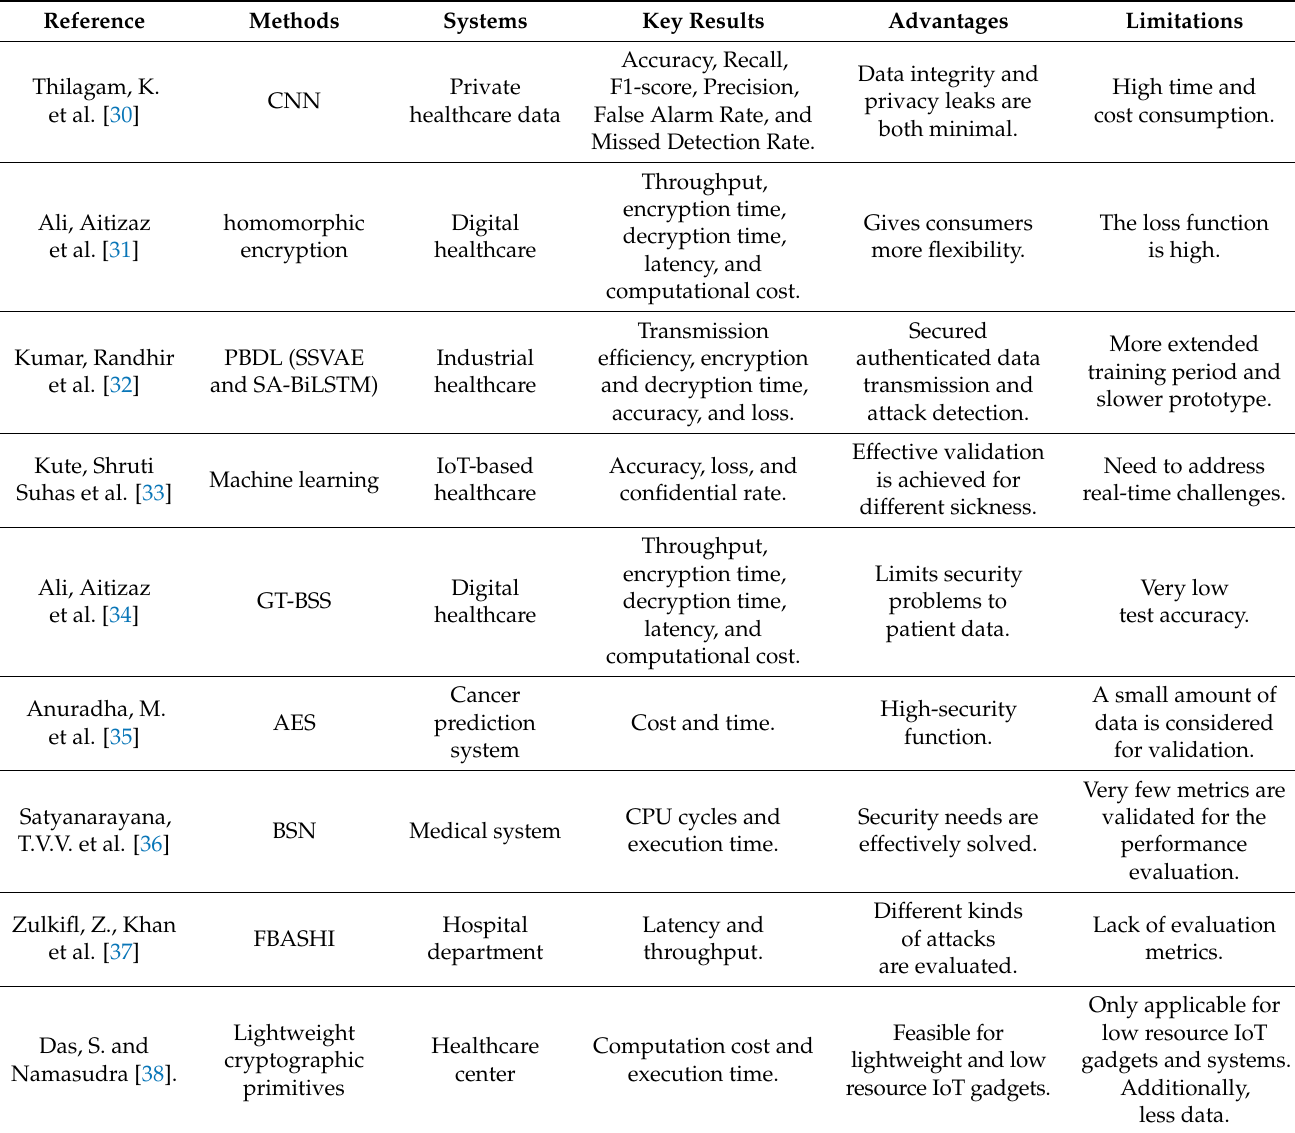
Table 1. The summary of related